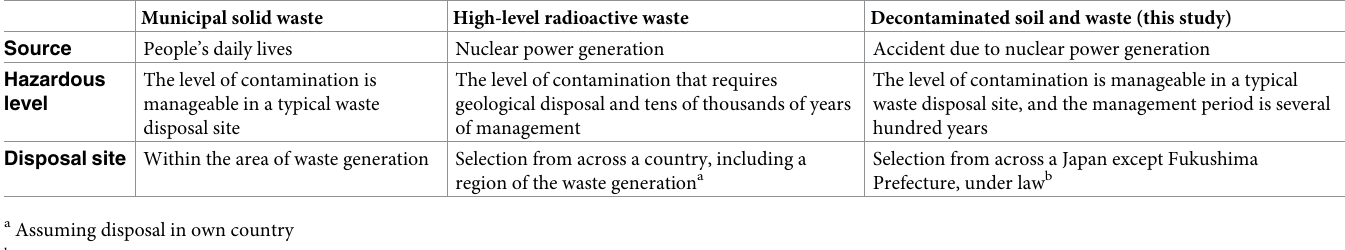
Table 1. Social perspectives on the disposal of traditional wastes and the contaminated soil and waste from the Fukushima accident. Municipal solid